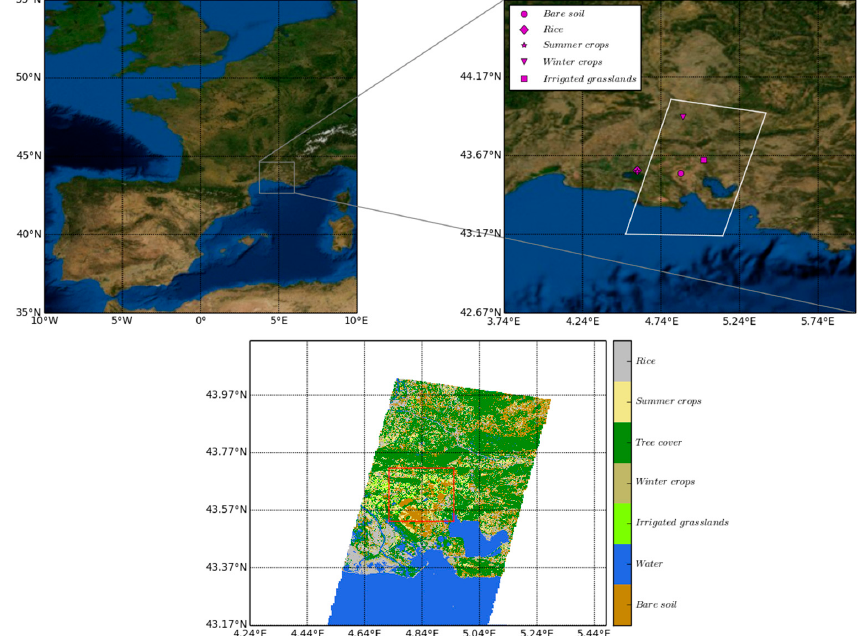
Figure 1. Crau-Camargue region and experimental sites equipped with micrometeorological measurements (upper panel). The white box delineates the region under study corresponding to the Landsat 7 frame. The land cover map of the study area is plotted in the lower panel. The red box indicates the region highlighted in the validation study.